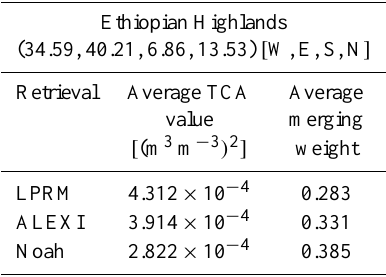
Table 2. Average merging weight and TC error values for Darfur.